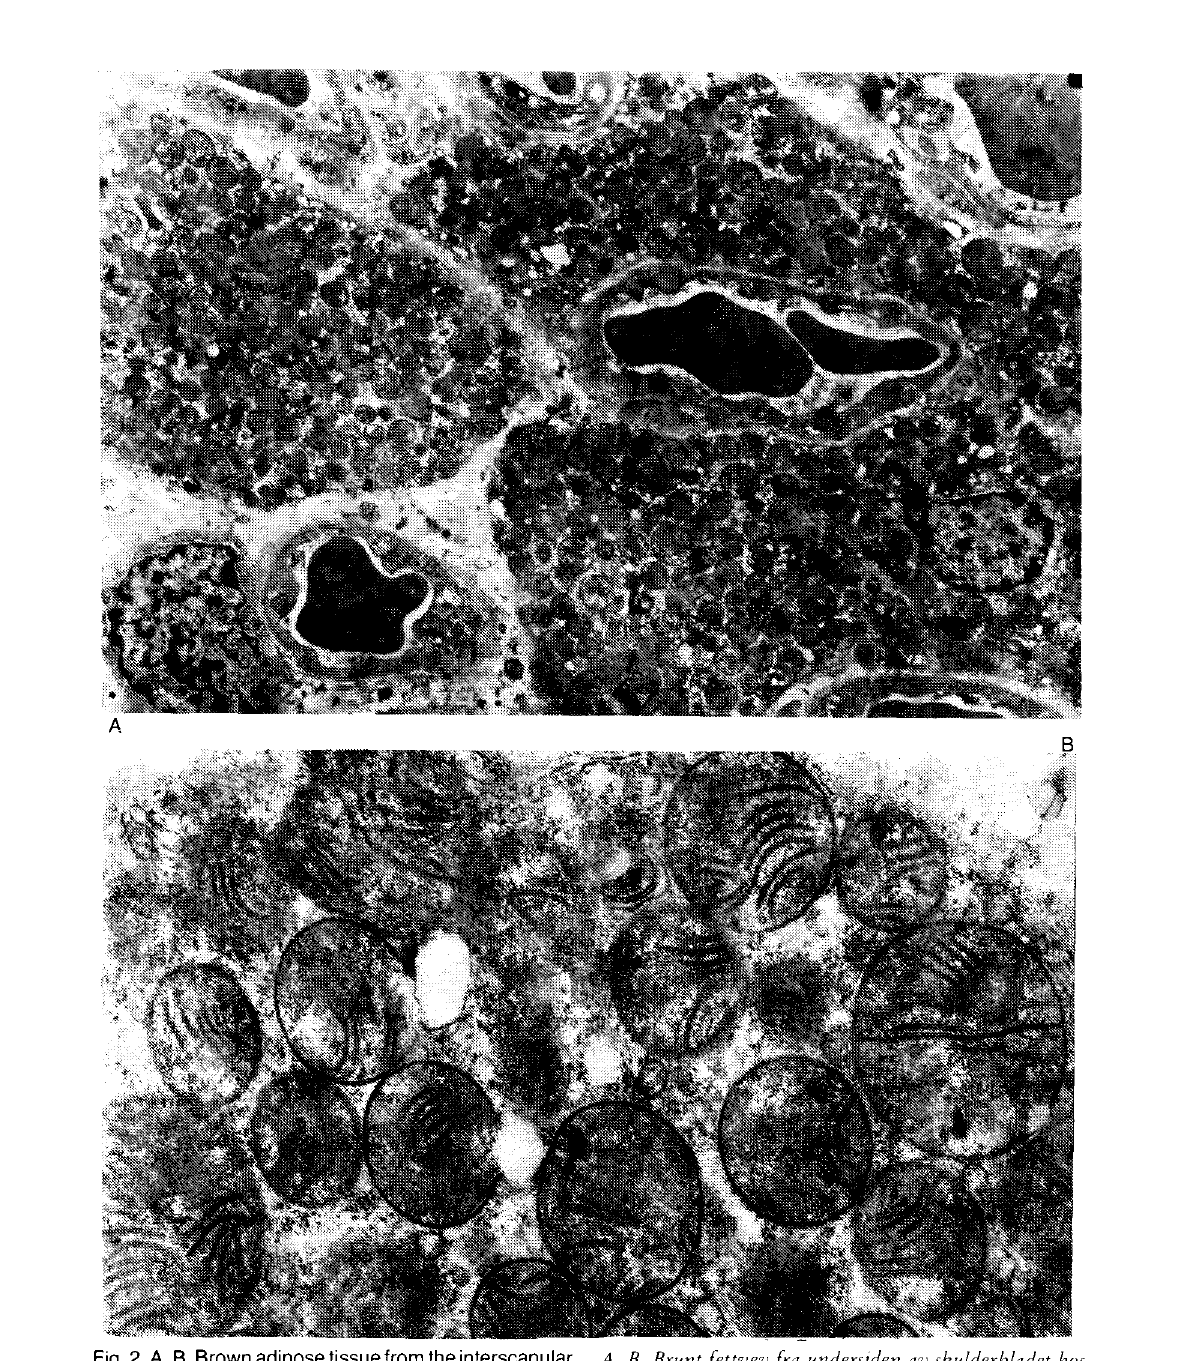
Fig. 2. A, B. Brown adipose tissue from the interscapular region of 1 day old reindeer calf, weighing 5.4 kg which had been exposed to the environmental temperature of appr. 5—10°C from birth. Typically the tissue contains few and small vacuoles of fat. Cells contain densely packed mitochondria with parallel